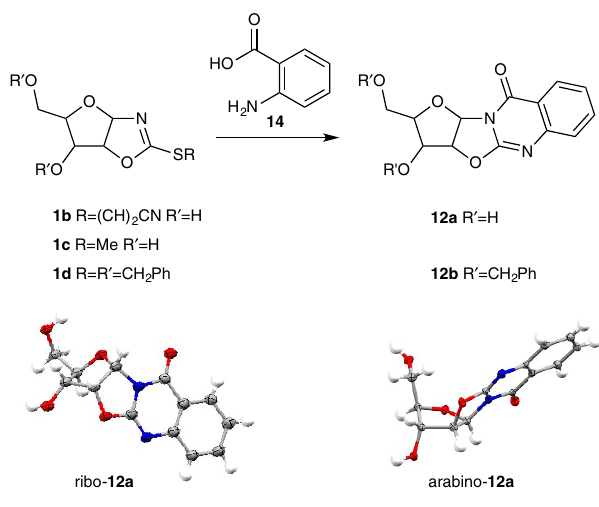
Figure 3 | Model quinazolinedione synthesis. One-pot cyanovinylation of arabinofuranosyl-oxazolidinone thione ( 1a ) and quinazolinedione 12a synthesis in water was tested as a model nucleobase synthesis strategy to investigate the pH dependence of cyanovinyl- and alkyl-sulfide displacement from S -cyanovinyl arabinofuranosyl-oxazolidinone thione ( 1b ) and S -methyl arabinofuranosyl-oxazolidinone thione ( 1c ), respectively. Single crystal X-ray structure of ribo-quinazolinedione (ribo- 12a ) and arabino-quinazolinedione (arabino- 12a